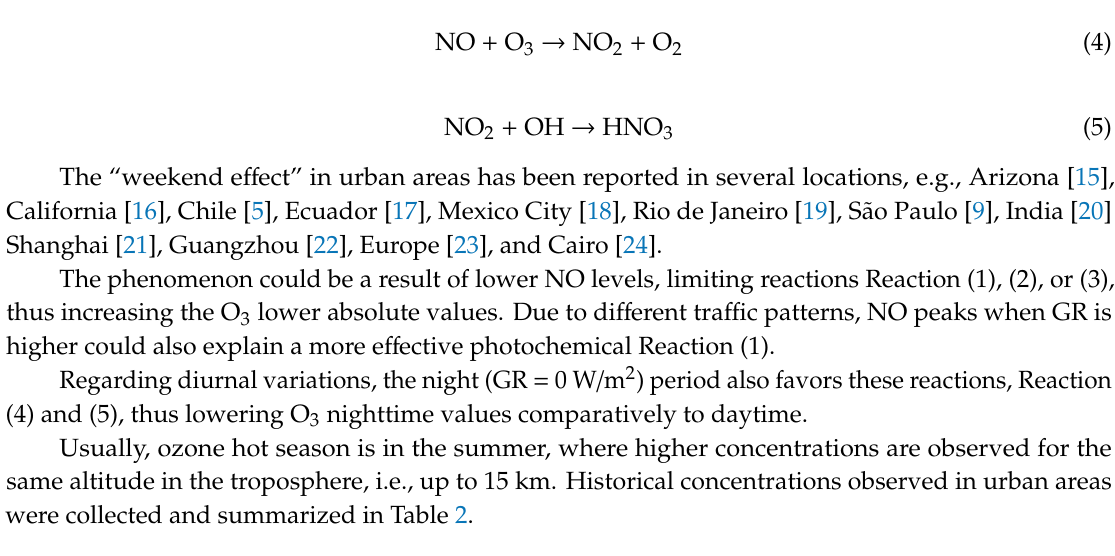
Table 2. Observed tropospheric ozone concentrations in urban areas from the literature review. Minimum (ppb) Maximum